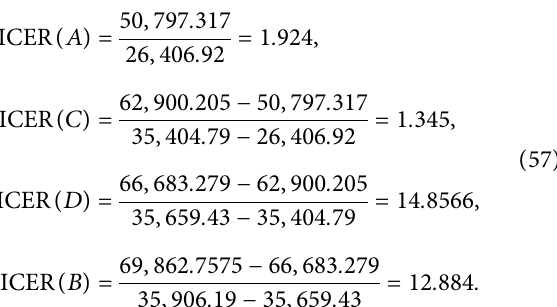
and vaccination u 1 2